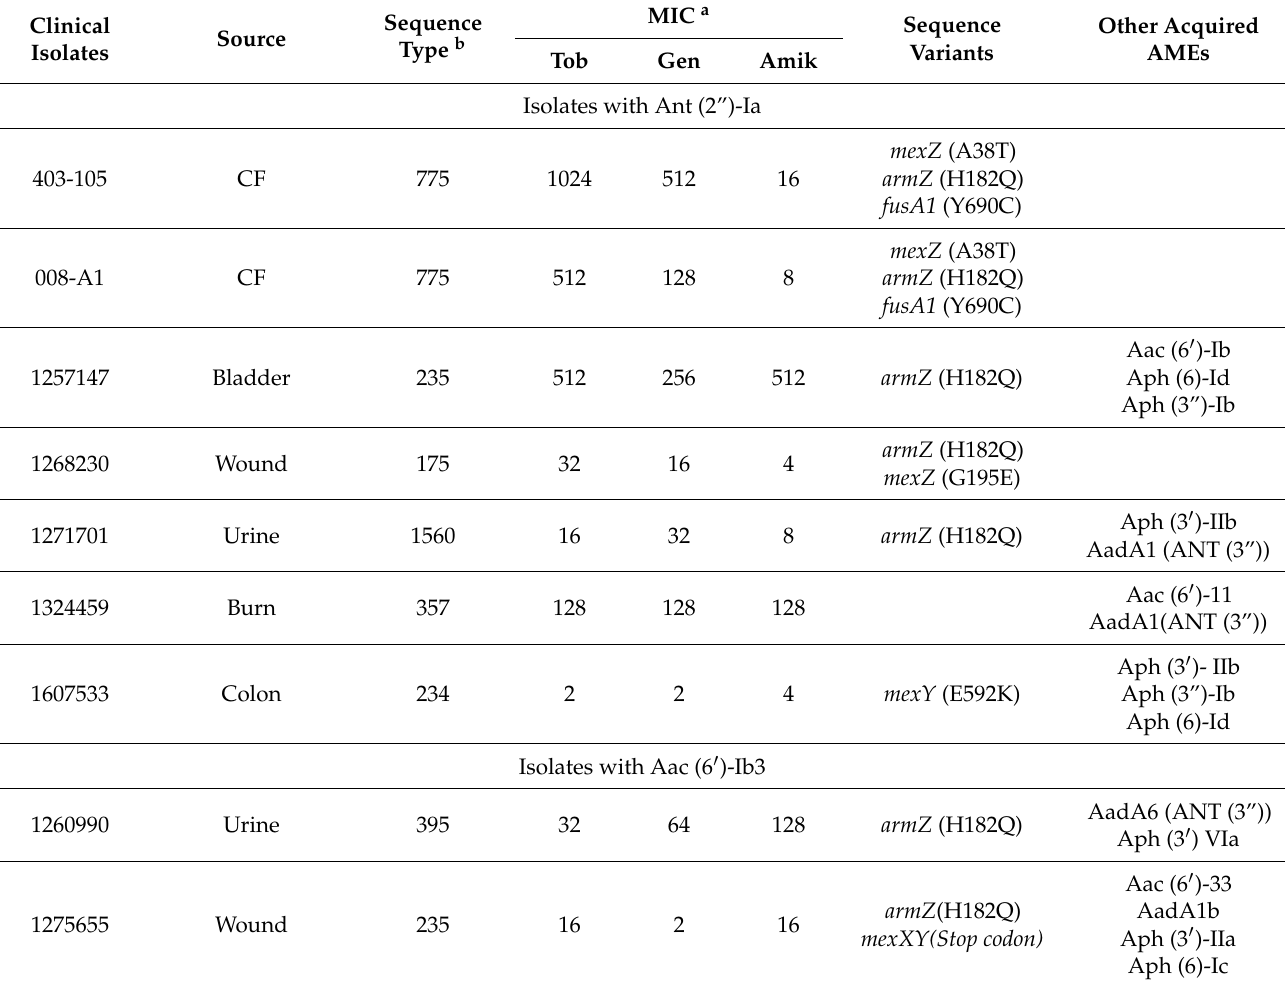
Table 1. Aminoglycoside resistance in isolates with frequently acquired